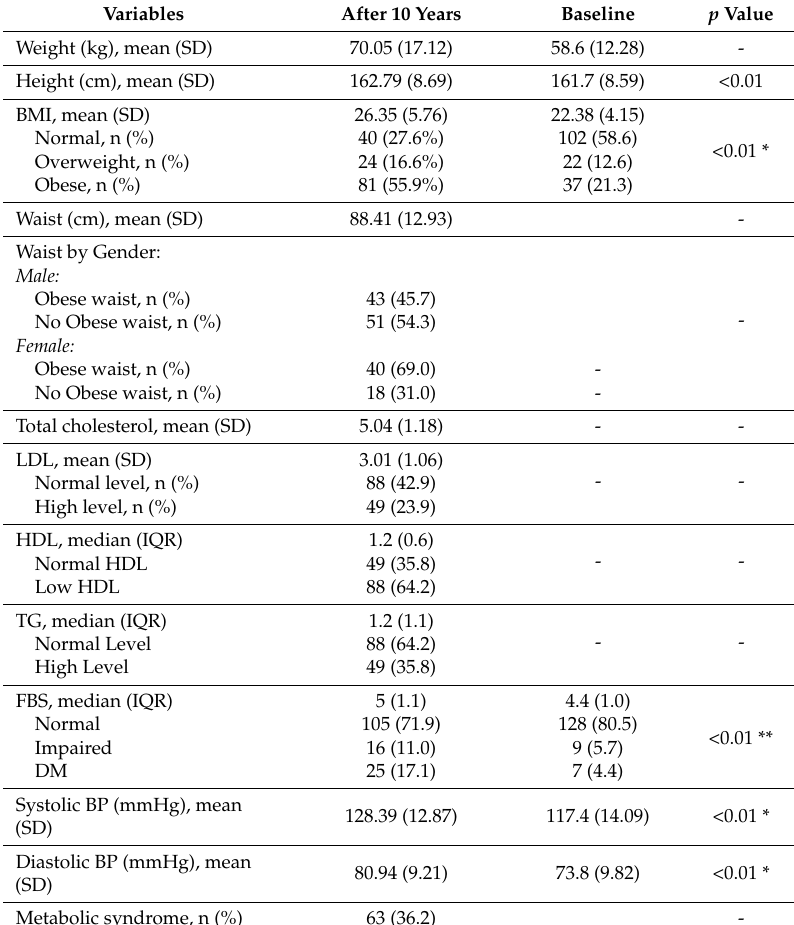
Table 3. Metabolic parameter measurements at baseline and after 10 years.